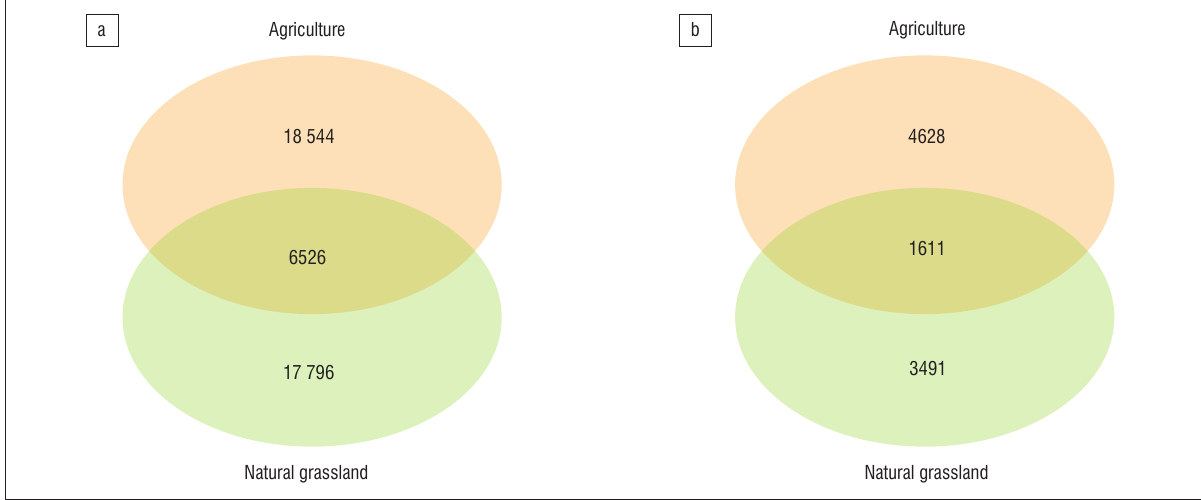
Figure 1: Venn diagrams of shared and unique (a) bacterial and (b) fungal operational taxonomic units between agricultural and natural grassland soil communities. Characteristics of sequences, diversity and richness between agricultural soils and natural grassland soils Bacteria Fungi Agriculture Grassland Agriculture